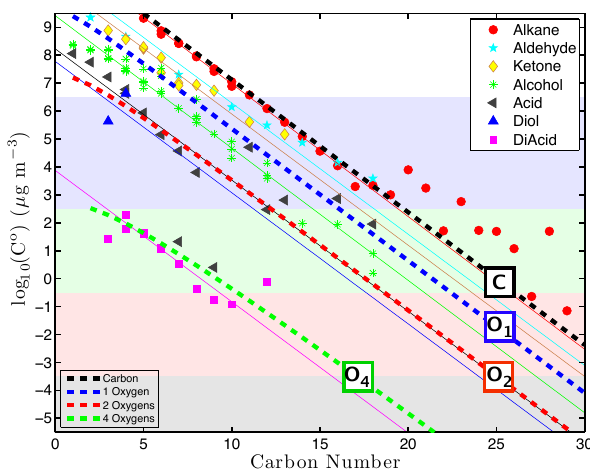
Fig. 3. Volatility ( C o ) predictions with modest nonlinearity ( b CO = − 0 . 3) in a group-contribution expression. As in Fig. 1, the average effect of oxygenated functionality is shown by thick dashed curves, which here show better agreement, especially with the